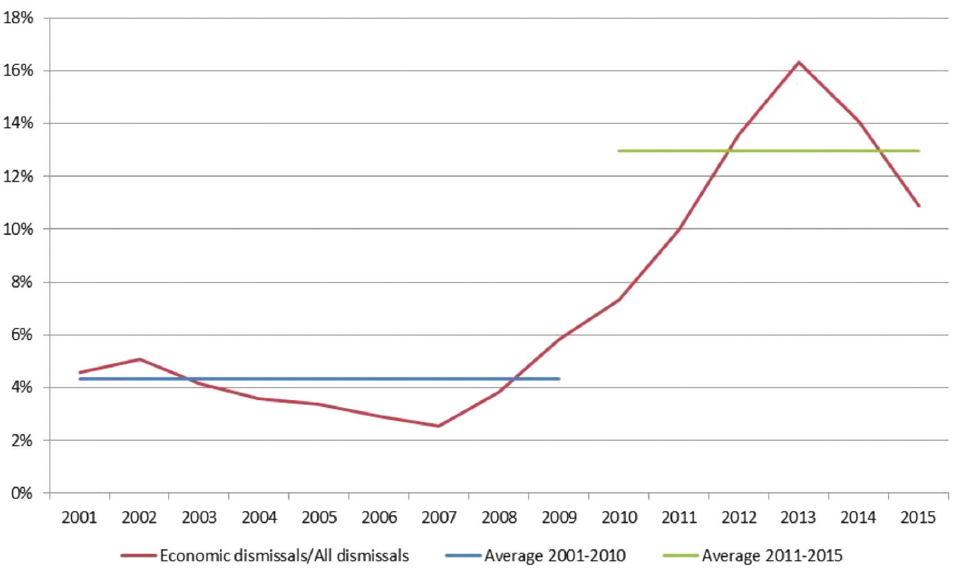
Source : Spanish Ministry of